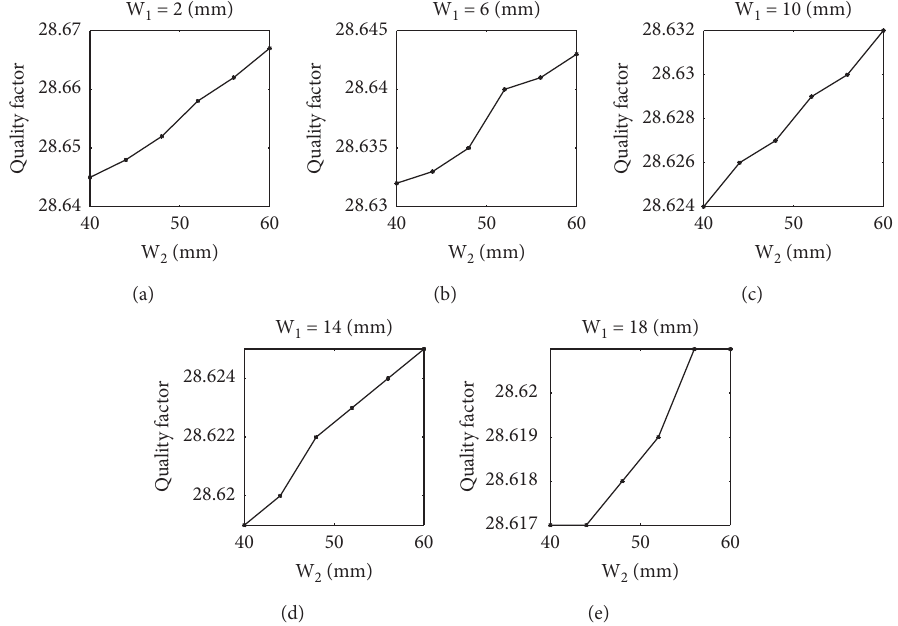
Figure 2: The quality factor of the first trapezoidal bimorph design. The structure loss factor is 0.025. The damping ratio is 0.017. The length of the beam L is 60mm, the thickness of T piezo is 0.3 mm, and the thickness of the brass layer T s is 0.05 mm.